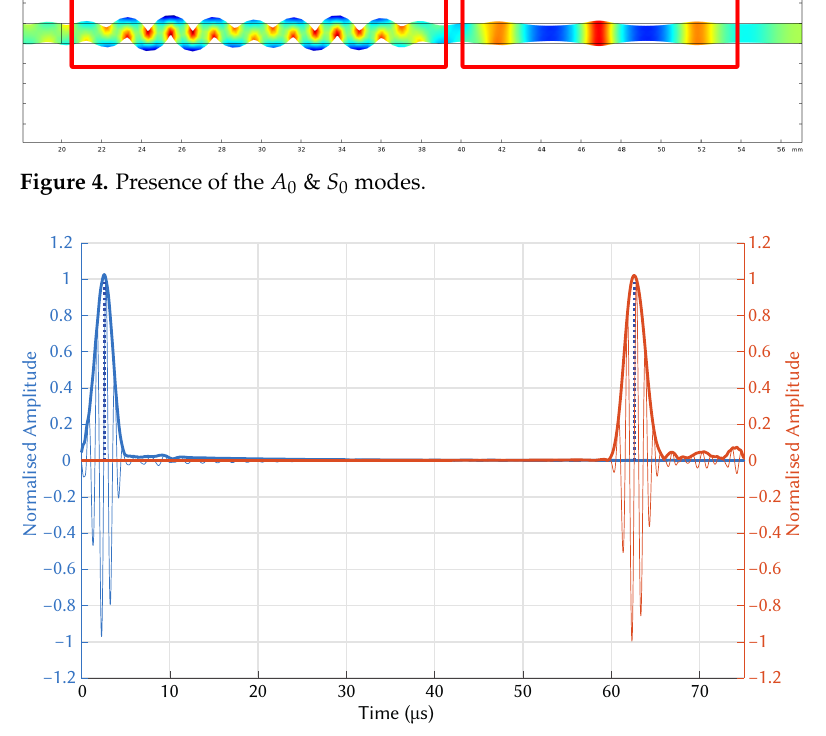
Figure 5. COMSOL simulation of S 0 mode propagation at room temperature.